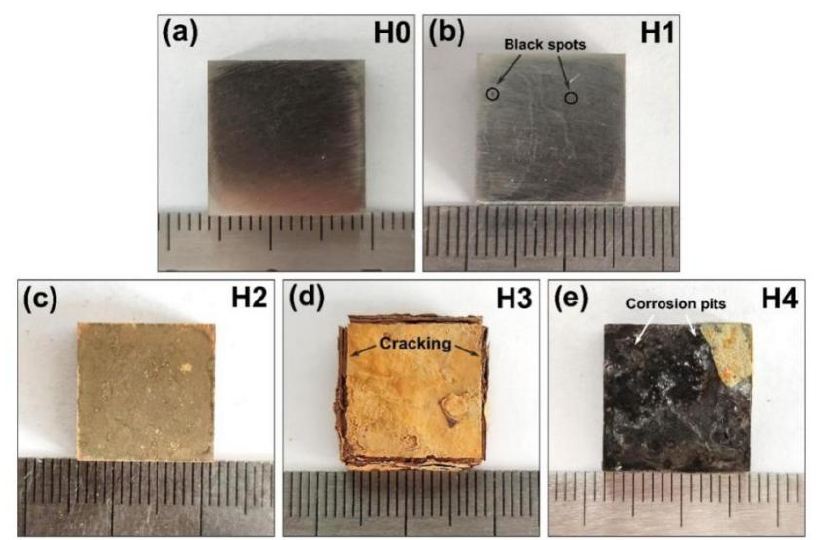
Figure 4. Macroscopic morphologies of all tested samples: ( a ) H0; ( b )H1; ( c ) H2; ( d ) H3; and ( e ) H4.